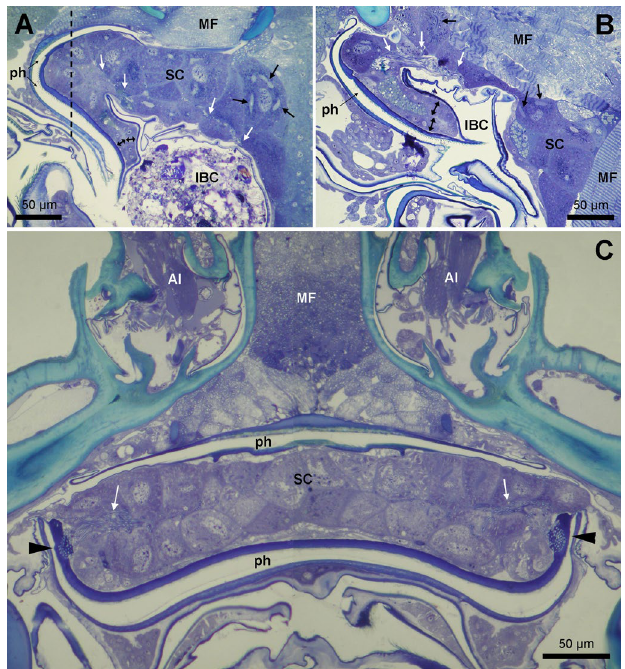
Fig 2 . Semithin longitudinal sections through propharyngeal gland: ( A ) at the body midline, ( B ) at the level of the lateral pharyngeal margin, showing the anterior bend of the pharynx. In both A and B, the anterior side is to the left. White arrows indicate gland ducts, black arrows show end apparatus in secretory cells. Double black arrows indicate epithelial infrabuccal cavity gland. C . Cross section at the level indicated by the dashed line in figure A, showing the grouped occurrence of the ducts and their opening into the pharynx through a lateral sieve plate at each side (black arrowheads). AI: antennal implantation, IBC: infrabuccal cavity, MF: muscle fibres, ph: pharynx, SC: secretory